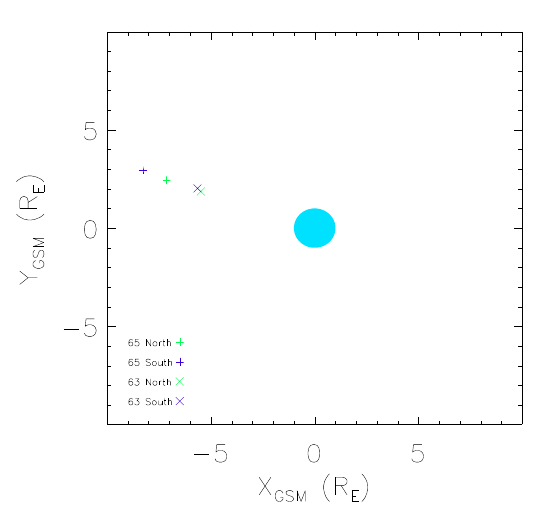
Fig. 10. Intersection of magnetic field lines with the GSM X − Y plane at 12:00 UT on 30 November 2002. The field-line tracing was performed using the Tsyganenko 96 model with IMF B y =10nT and B z = − 5nT. The results are shown for evening sector (pre-midnight) magnetic field lines with ionospheric magnetic latitudes of ± 63 ◦ 3 and ± 65 ◦ 3